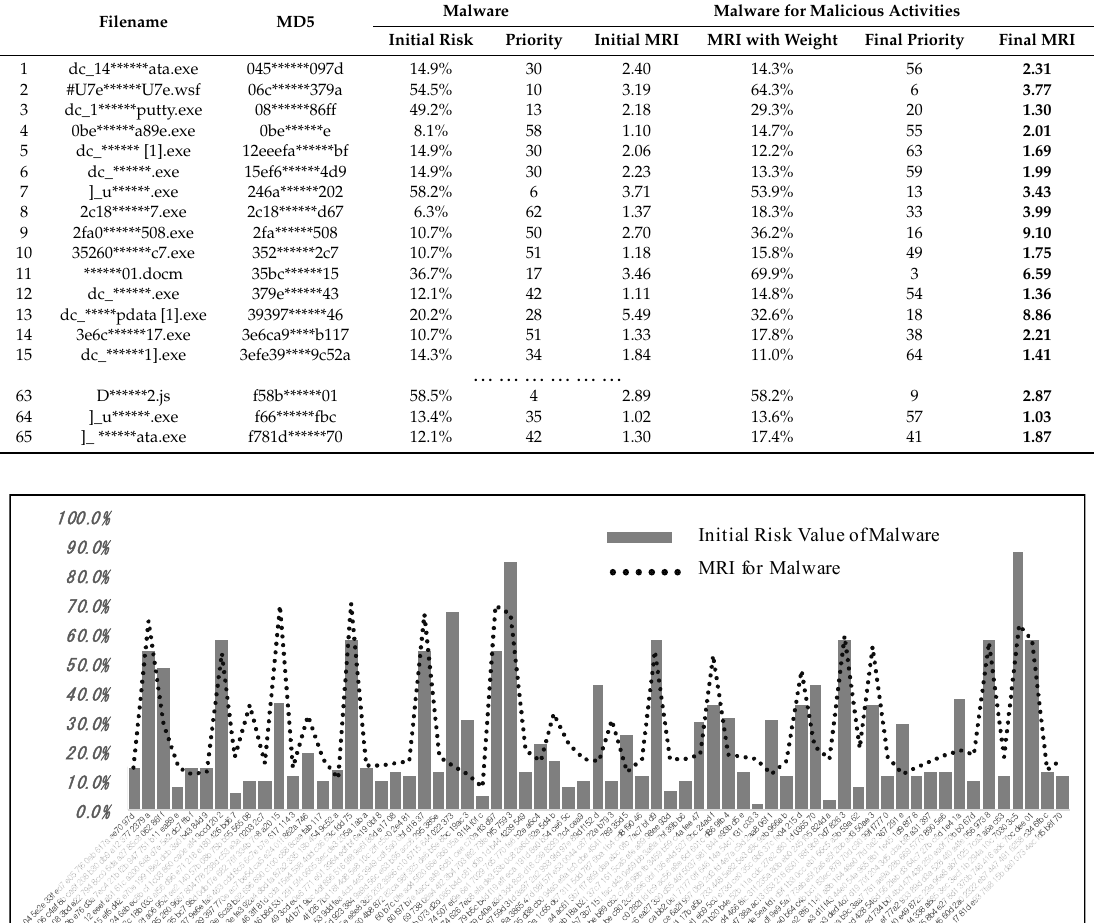
Table 4. Malware’s initial risk and MRI value that considers the MA. (MRI with weight). Malware Malware for Malicious Activities MD5